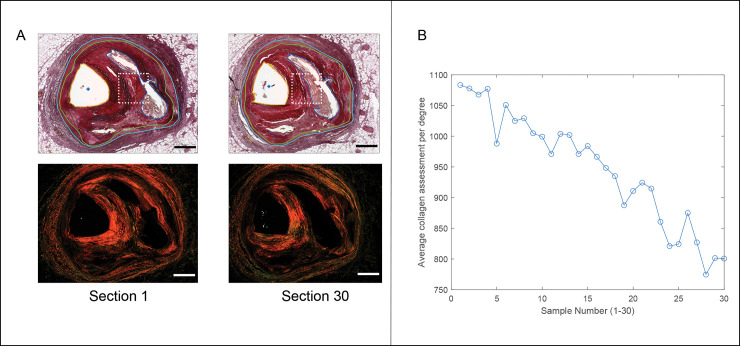
Responsivity of pixel counting to changes in cap thickness.(A) First and last of thirty serial sections (each cut at 7 μm thick), illustrating changing thickness of necrotic core and cap thickness at mid region of necrotic core arc (dotted white box), bright light images (top) and polarized images (bottom). Scale bars = 1 mm. (B) Plot of pixel counting method illustrating decreasing magnitude of positive cap pixels throughout the sections as the cap thickness decreases.